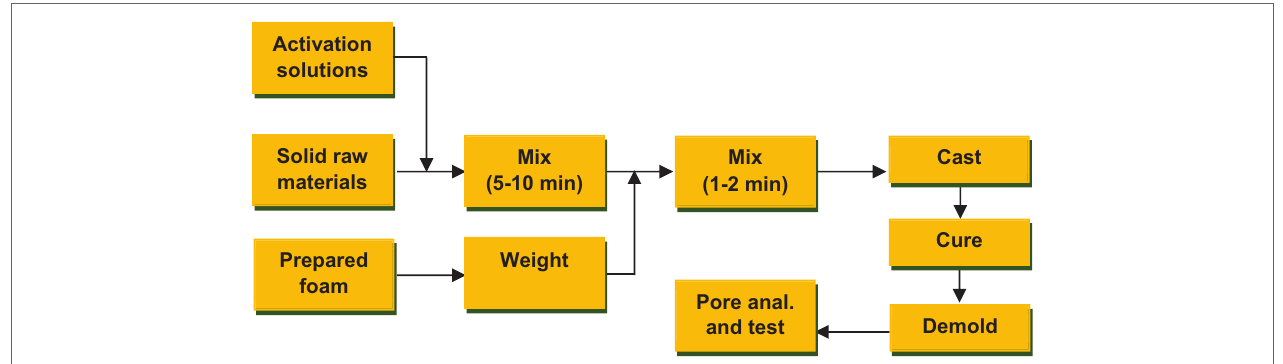
FigUre 1 | gFc laboratory manufacturing process